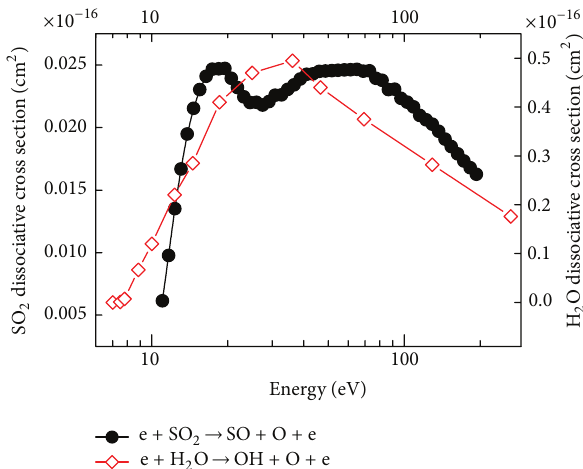
Figure 3: The relationship between electron collision dissociative cross sections and the collision energy.